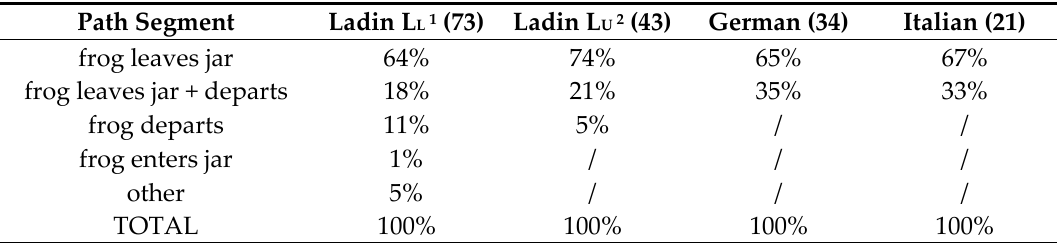
Table 5. Group comparison of segment-coding for the frog’s ‘journey from the jar’. Path